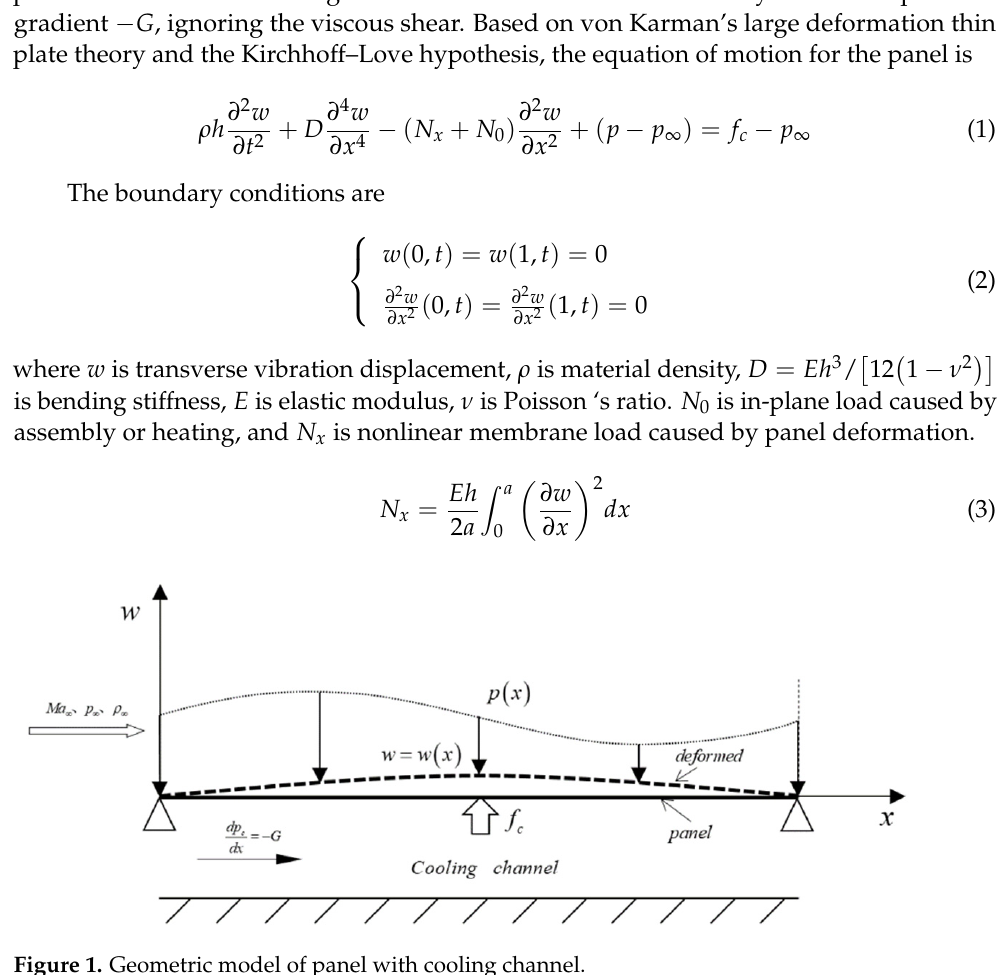
Figure 1. Geometric model of panel with cooling channel.